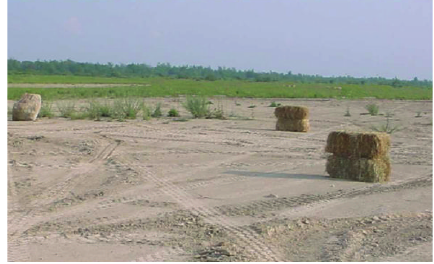
Figure 2: The test site at Ft. Drum, NY, where the data for this experiment were taken.